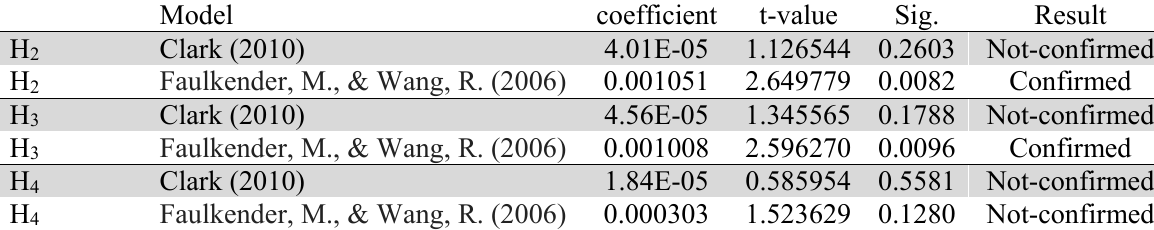
The results of examining the second to fourth hypothesis